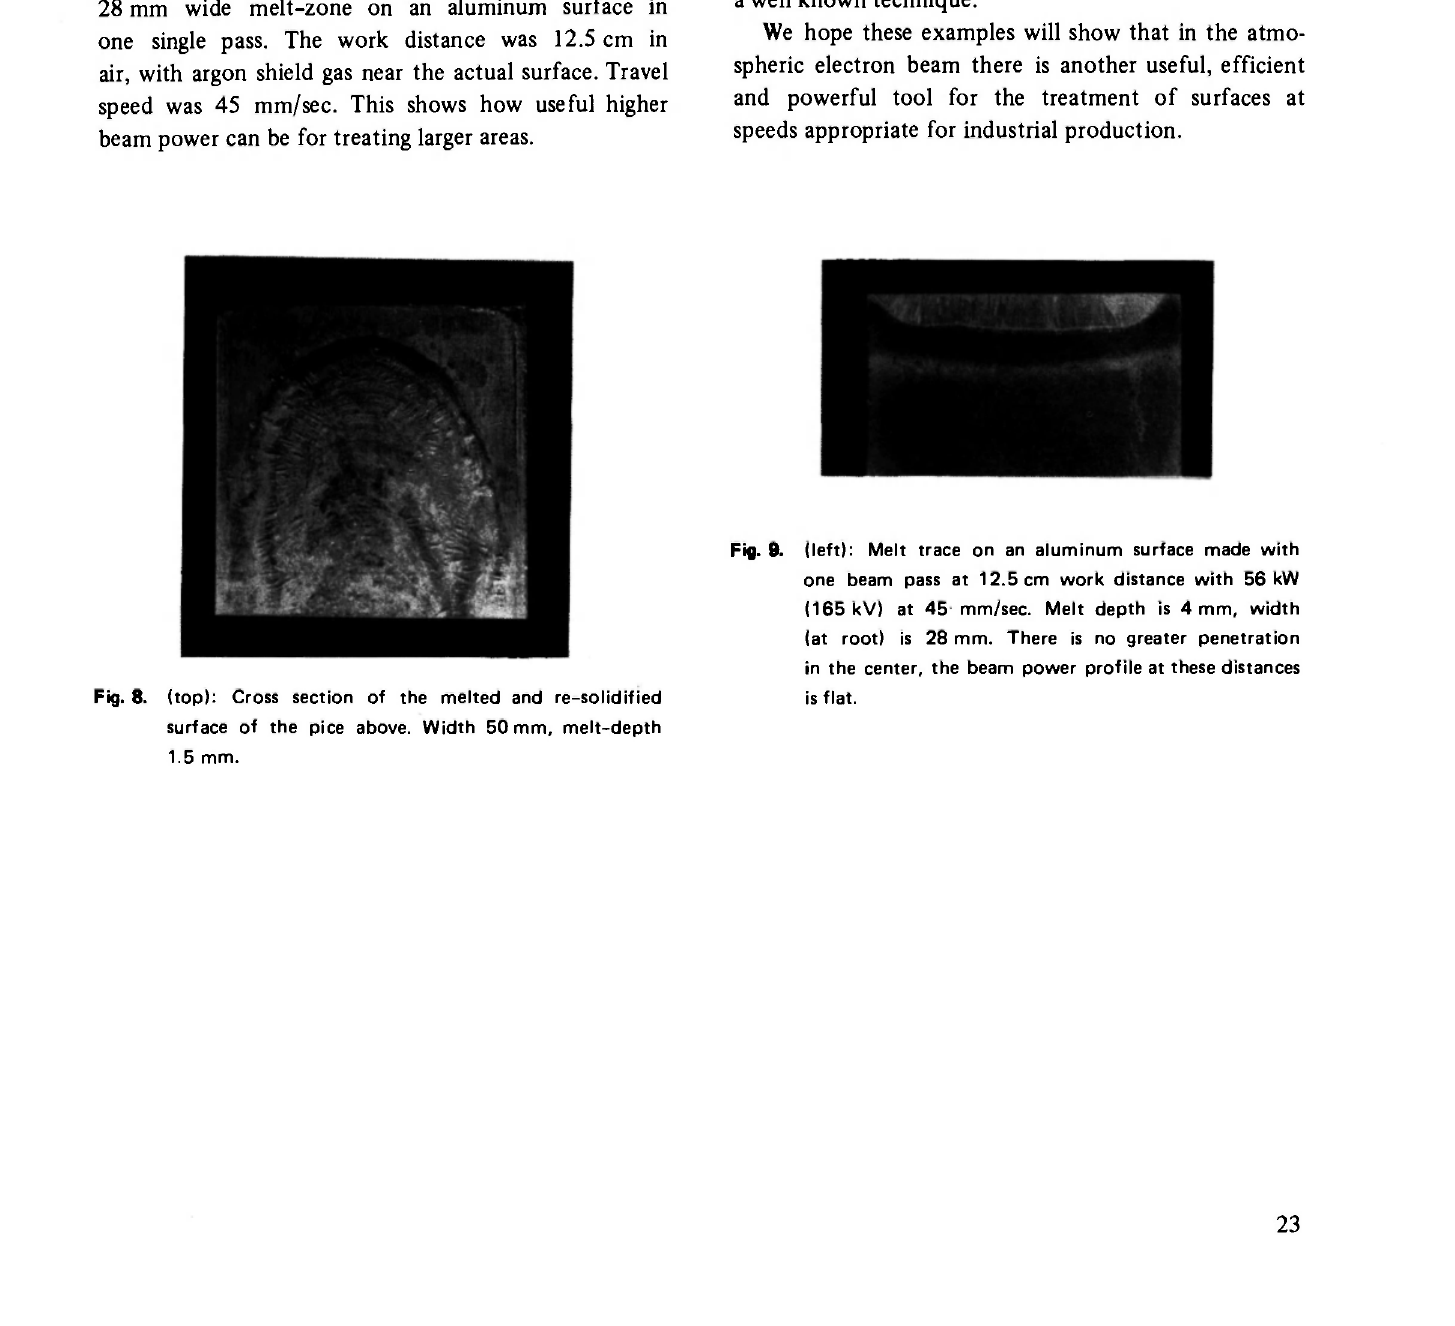
Fig. 8. (top): Cross section of the melted and re-solidified surface of the pice above. Width 50 mm, melt-depth 1.5 mm.